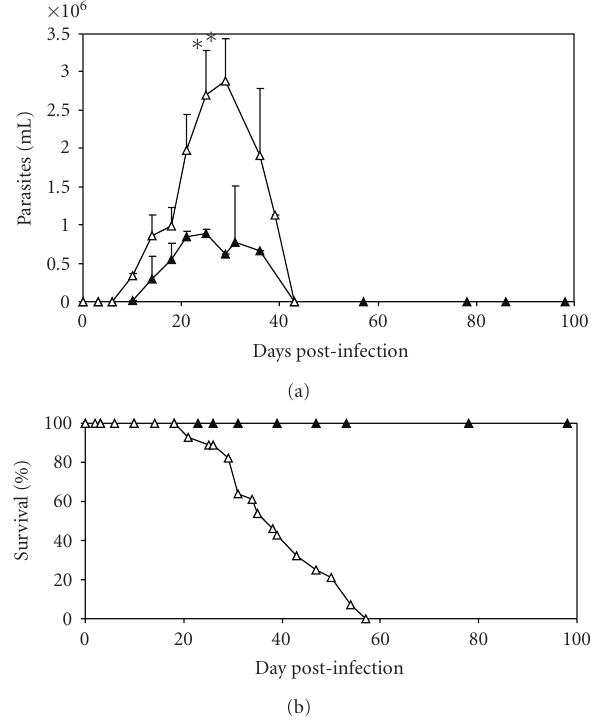
Figure 1: Parasitemia and Survival curve in mice infected with T. cruzi BT. Mice were inoculated ip with 1 × 10 4 BT Ninoa ( ) strains. (a) Parasite number in blood was determined or Qro ( (cid:2) by counting in a Neubauer chamber using an optic microscopy. Statistical di ff erences in blood parasite number are indicated ( ∗ P < . 05) at 25y 29 days post infection. (b) Survival of mice infected with T. cruzi strains was evaluated using groups of 28 mice infected with T. cruzi strains. Daily direct observation was done and dead mice were